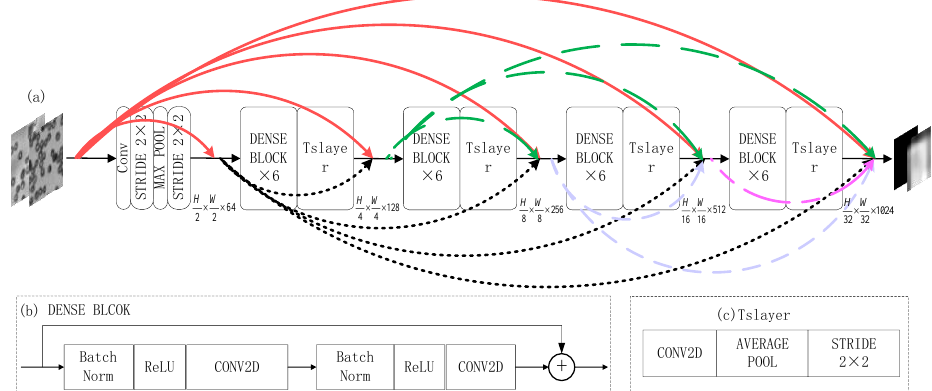
Figure 5. Migration of DenseNet121 base-layer network model framework: ( a ) schematic diagram of base-layer network model; ( b ) DENSE BLOCK network structure module; ( c ) Tslayer network structure module.